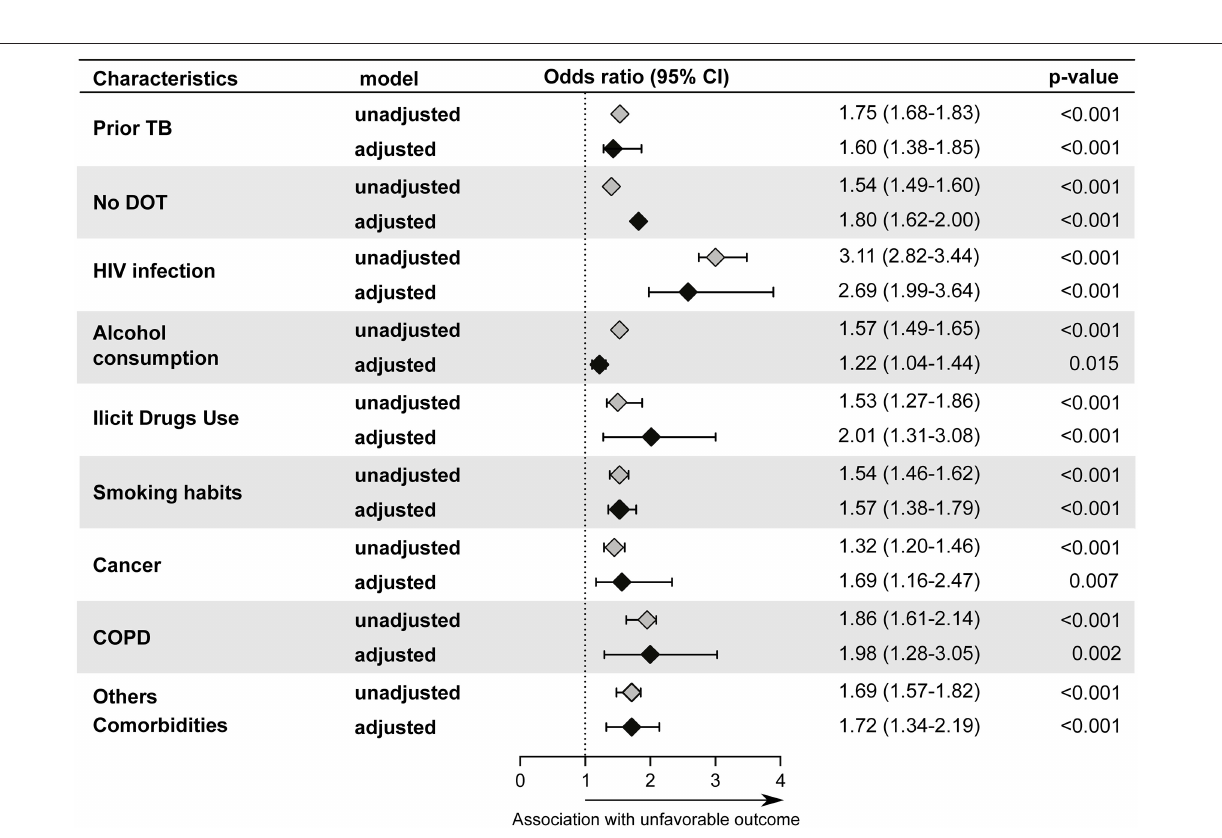
FIGURE 5 | HIV infection); Alcohol Consumption (reference: no alcohol consumption); Diabetes (reference: no diabetes); Illicit drug use (reference: no illicit drug use); Smoking habit (reference: no smoking). Cancer (reference: no condition); COPD (reference: no condition); Kidney disease (reference: no condition); Hypertension (reference: no condition); Other comorbidities (reference: no condition); Abnormal chest X-ray (reference: normal chest X-ray). TB, tuberculosis; DOT, directly observed treatment; COPD, chronic obstructive pulmonary disease.